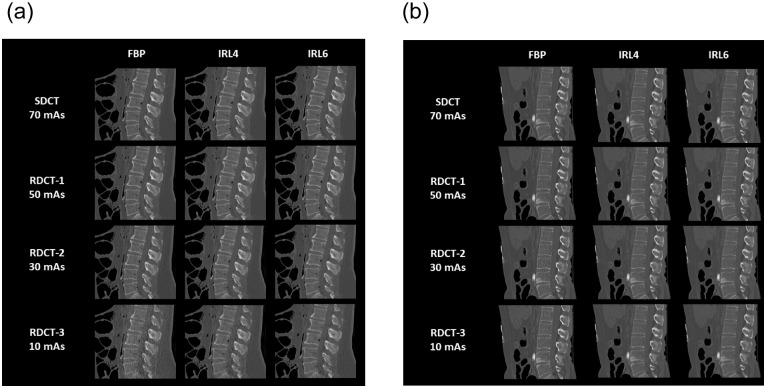
a. All CT protocols (SDCT and RDCT-1, 2 and 3) reconstructed with FBP and IRL4 and IRL6 in sagittal reformations. b. As for Fig 1a, but images were obtained from a male cadaver (age at death: 53 years; BMI: 20.8 kg/m2).